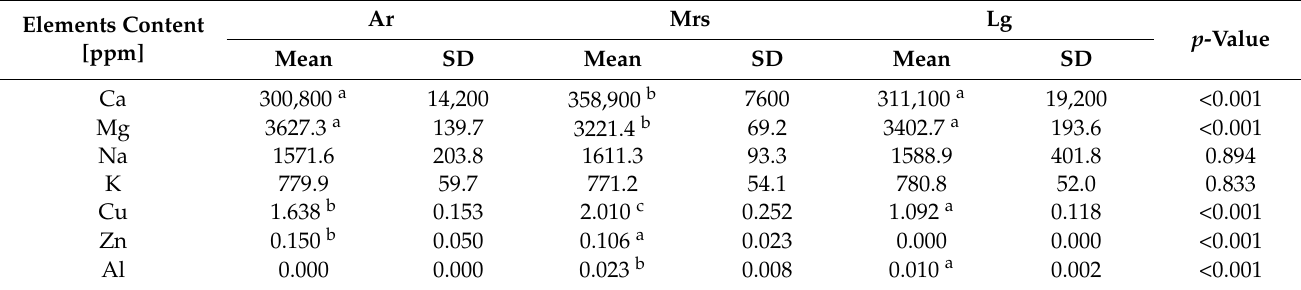
Table 5. The shell mineral composition of of eggs from three breeds of hens differentiated by the eggshell color. Elements Content